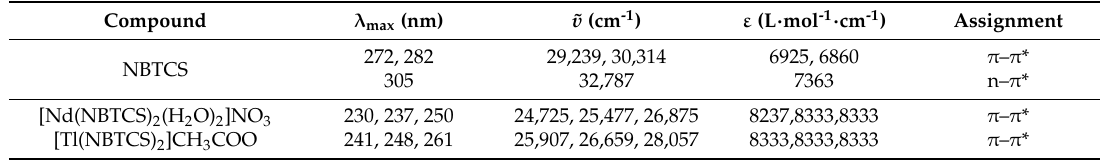
Table 2. UV-Vis spectral data λ max (nm) of NBTCS and complexes.